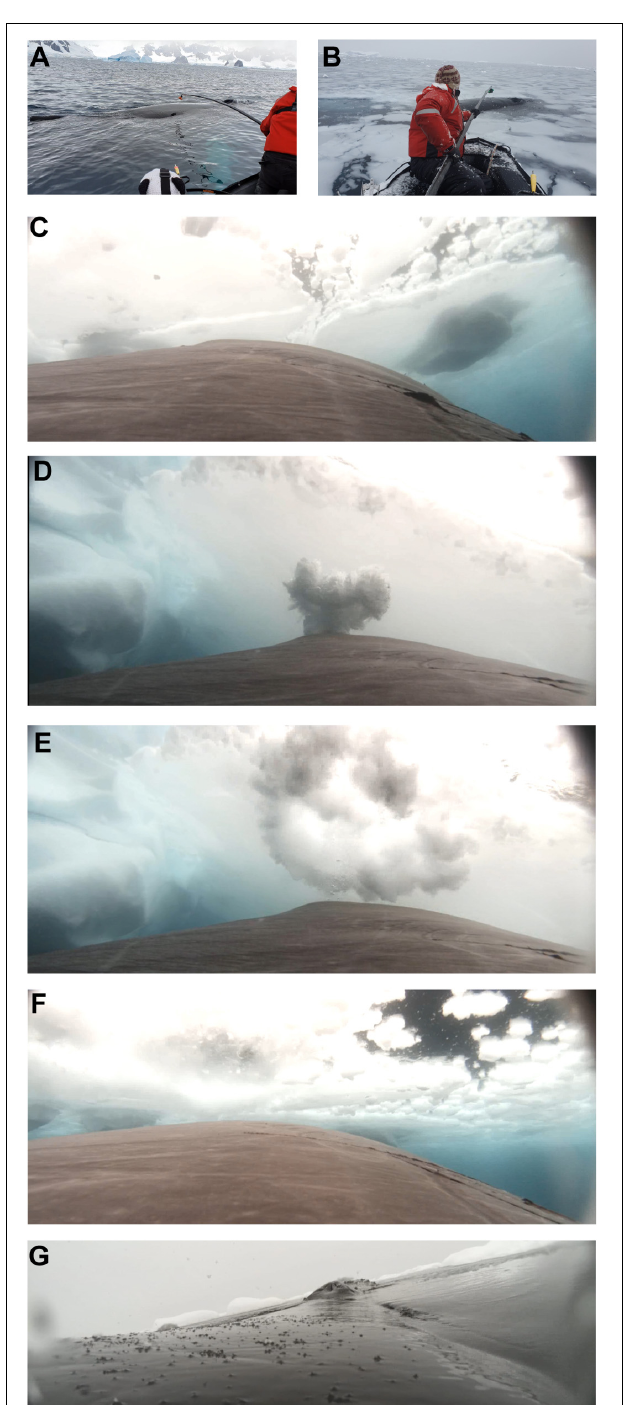
FIGURE 5 | Environmental conditions in both bays. (A) In Charlotte Bay, all tags were deployed in ice free water and whales were not observed in icy conditions. (B) In Wilhelmina Bay, the two tags deployed on whales that subsequently foraged were in an icy inlet ( Figure 1 ). (C–G) Still images from mn200315-58 in Wilhelmina Bay, clearing ice via bubble blasts to surface in open water ( Supplementary Video 2 ). Stills D&E were from an earlier event than the other stills, but were included as representative of the process since they were clear images. Photo credits (A,B) : Ryan Houston.